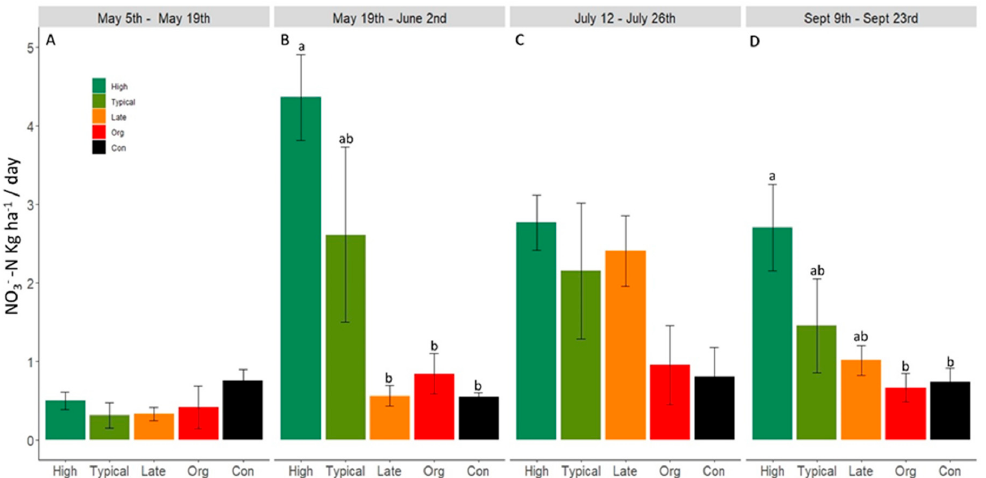
Figure 6. Potentially mineralizable nitrogen for High fertilizer (High), Typical fertilizer (Typical), Late incorporation (Late), Organic and control shown as mineralized (NO 3 − -N) during 5th May to 9th May ( A ); 19th May to 2nd June ( B ); from 12th July to 26th July ( C ); and from 9th September to 23rd September ( D ) incubation periods. Different letters indicate significant differences ( p < 0.05).